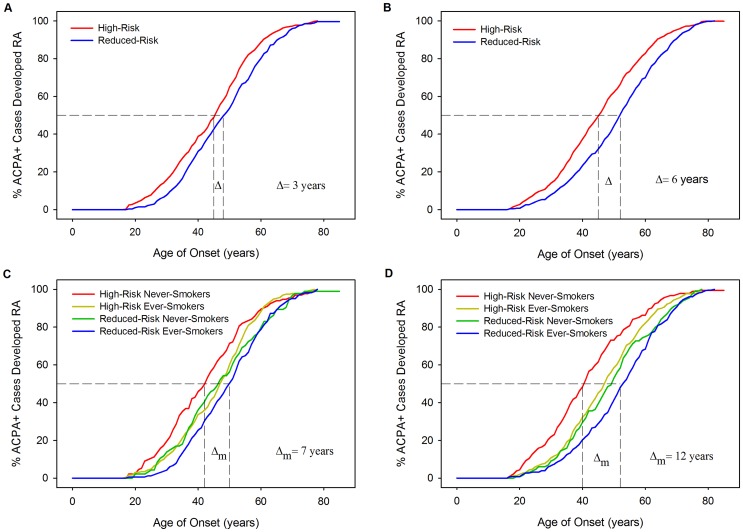
Kaplan-Meier curves: RA age of onset stratified by HLA model risk categorisation and smoking status.Panel A = WTCCC Curves Stratified By Risk Categorisation; Panel B = UKRAGG Curves Stratified By Risk Categorisation; Panel C = WTCCC Curves Stratified By Risk Categorisation and Ever-Smoking Status; Panel D = UKRAGG Curves Stratified By Risk Categorisation and Ever-Smoking Status; Δ = change in onset age; Δm = maximum change in onset age across strata.